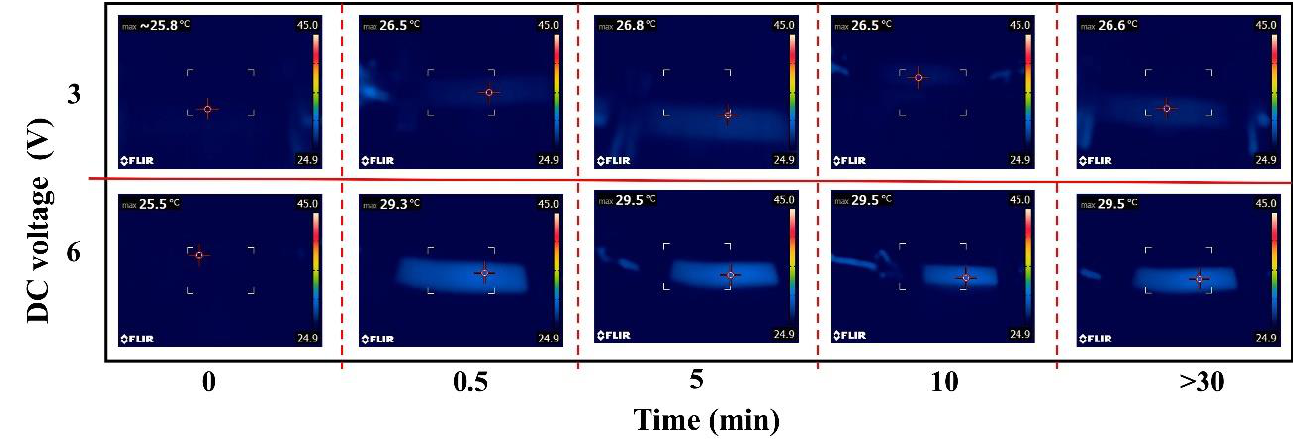
Figure 2. Temperatures changes under the applied voltage of 3 and 6 V, tested in ∥ direction.